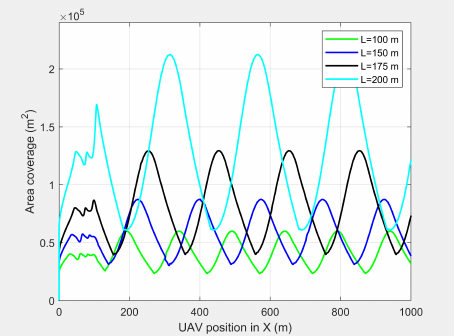
Figure 6. The UAV’s look-ahead coverage when following the MGV for different L values.